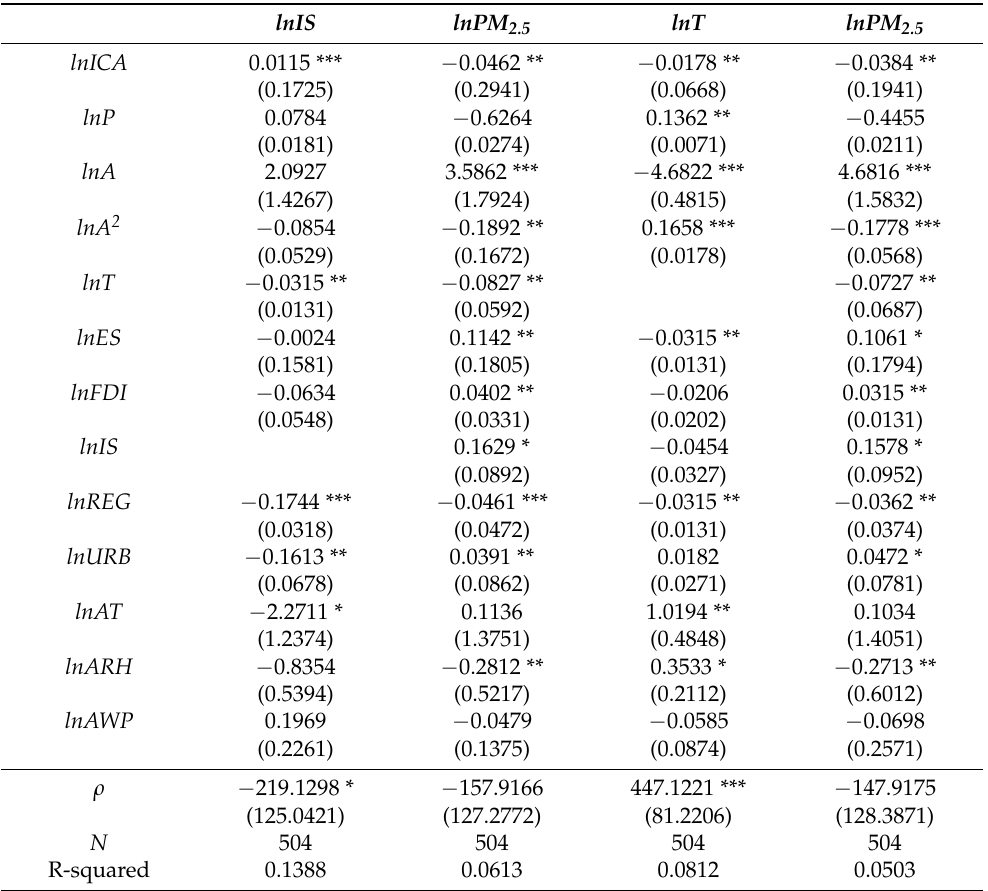
Table 8. Empirical results of the influence path of the coordinated agglomeration of manufacturing industry and producer services on PM 2.5